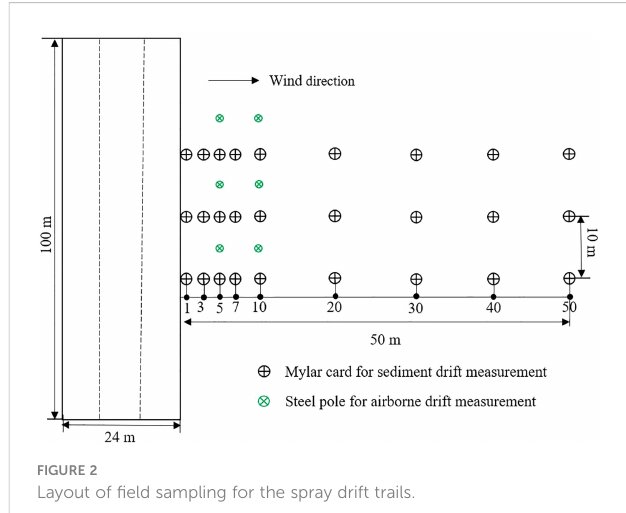
FIGURE 2 Layout of fi eld sampling for the spray drift